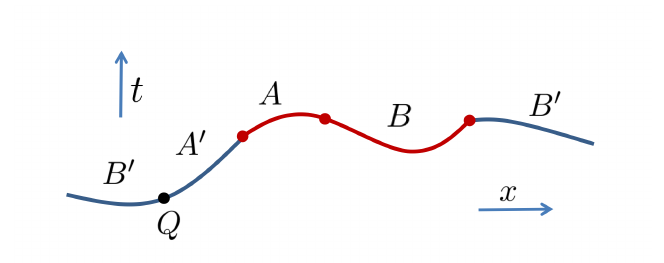
Figure 2: Setup for two adjacent covariant intervals A and B in the vacuum state of a CFT with gravitational anomalies. The auxiliary system A (cid:48) B (cid:48) is the complement of 2 AB on the spatial curve, and is partitioned by the point Q